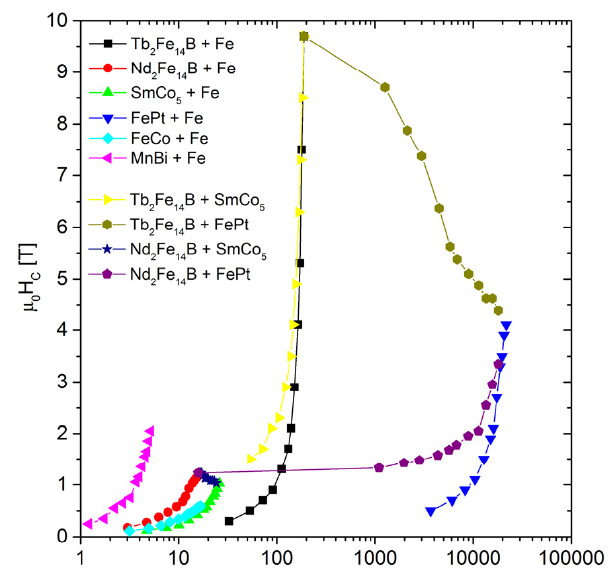
Figure 13. Coercive field as a function of the estimated price of the elements.